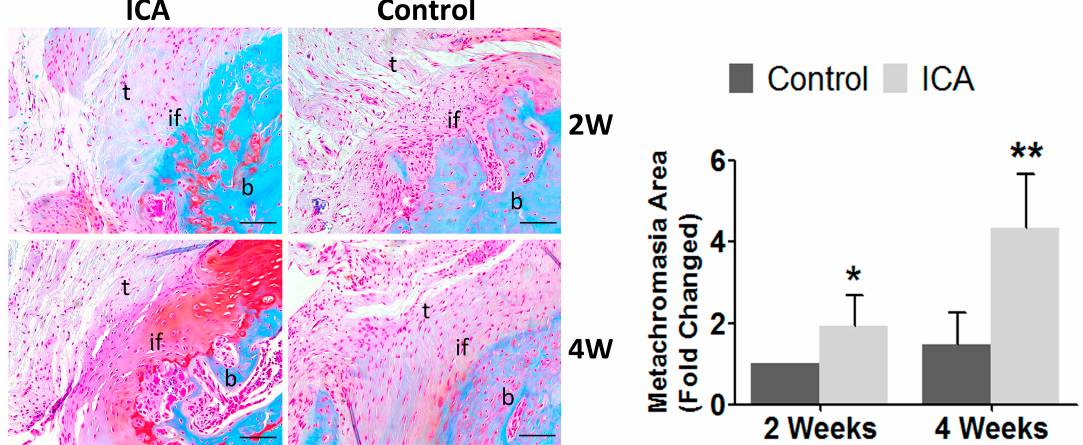
Figure 3. Representative images (total magnification, 100×) of Safranin O/Fast Green staining to assess fibrocartilage formation at the enthesis. Stronger proteoglycan staining was observed at the tendon-bone interface in the ICA group compared to the control group. Larger area of cartilage present at the insertion site as determined by metachromasia with safranin O–stained were observed in the ICA group, when compared with the control group. 2W: two weeks postoperatively; 4W: four weeks postoperatively; t: tendon; b: bone; if: tendon-bone interface. Semi-quantitative analyses were conducted using Image J software (National Institutes of Health). * p < 0.05, ** p < 0.01, bar = 200 µ m.